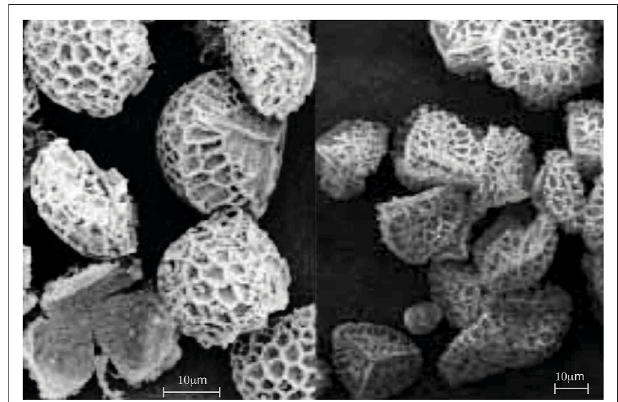
FIGURE 2 | Exines produced from Lycopodium clavatum . Left image showsSEMsofexineswheresomearefractured,andright,processedspores where the exines are not